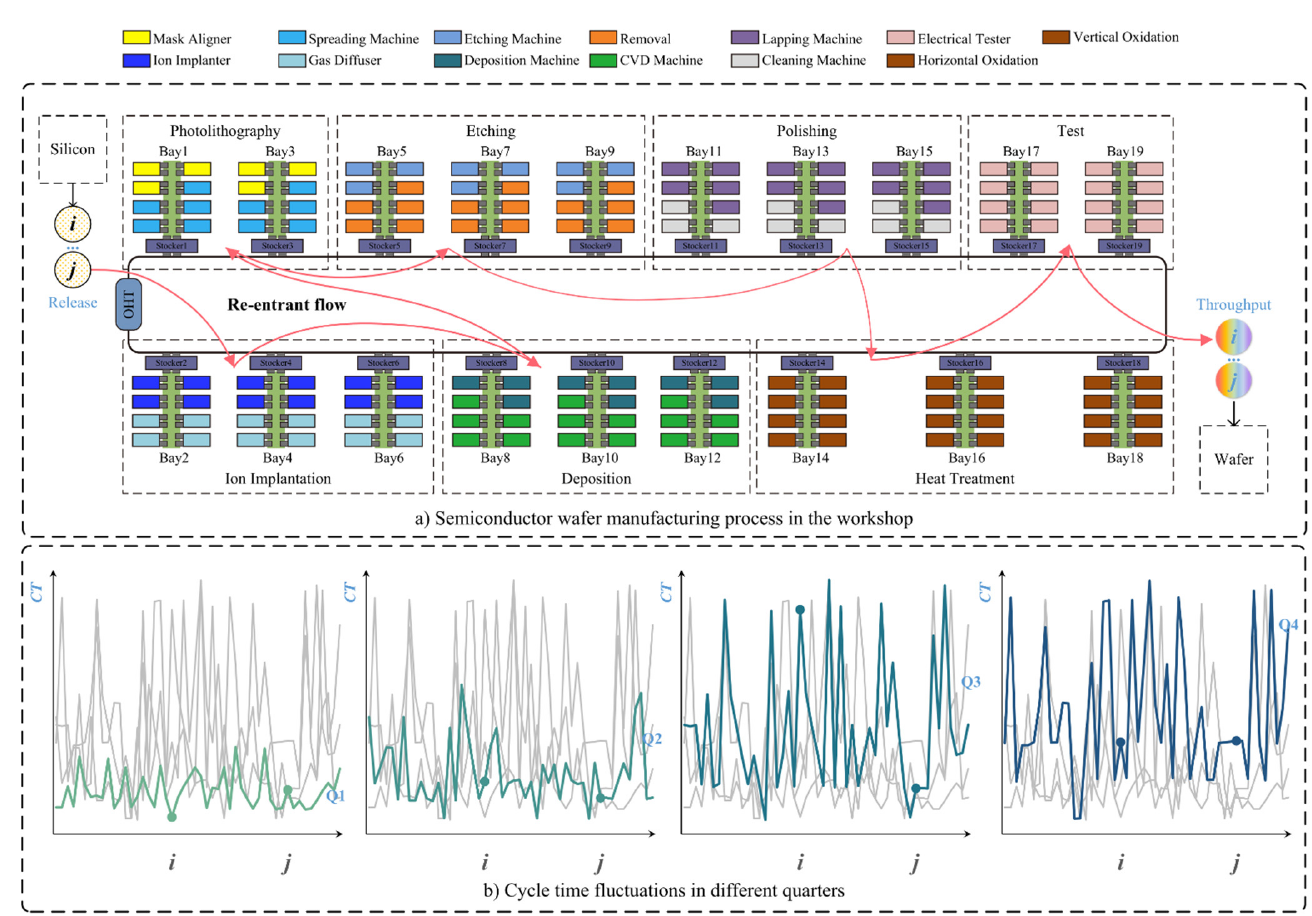
Figure 1. Huge and complex semiconductor wafer fabrication system and cycle time in different quarters.